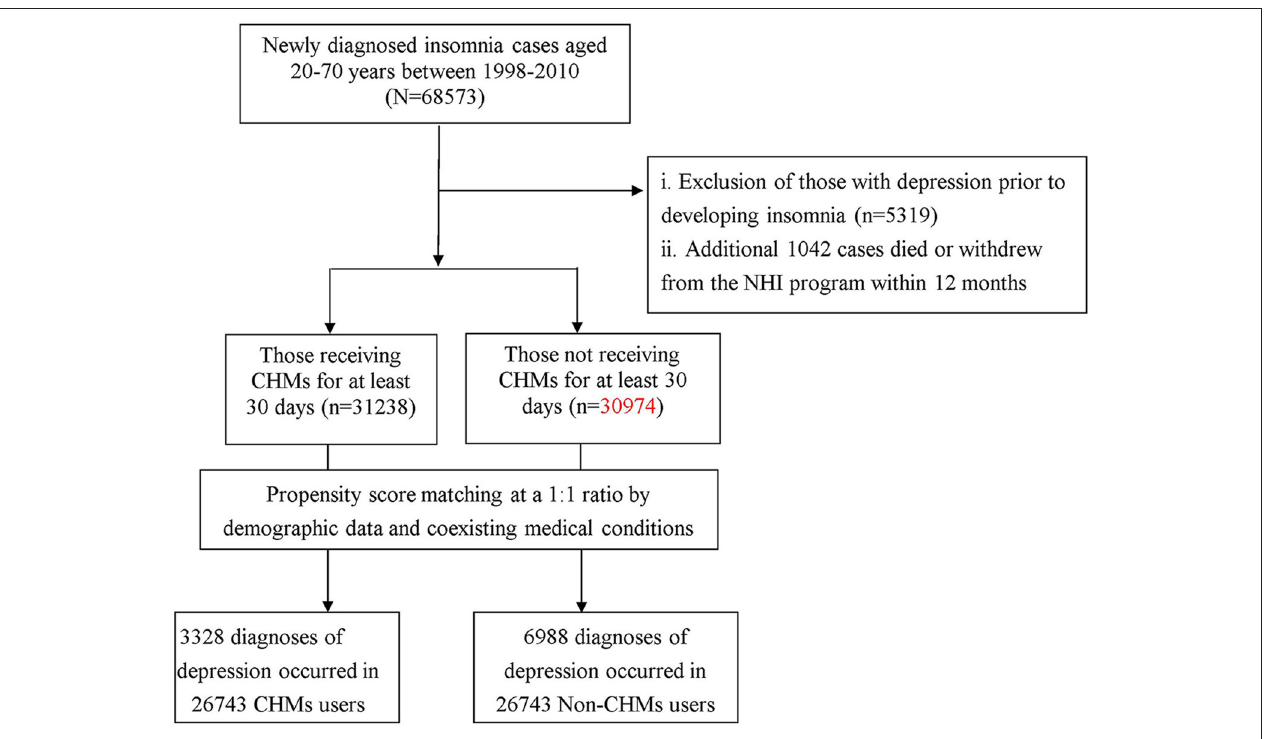
FIGURE 1 | Flow chart of selection and follow-up of study subjects. and 2010 (ICD-9-CM codes: 307.41, 307.42, 780.50, 780.52), were considered for enrollment into the